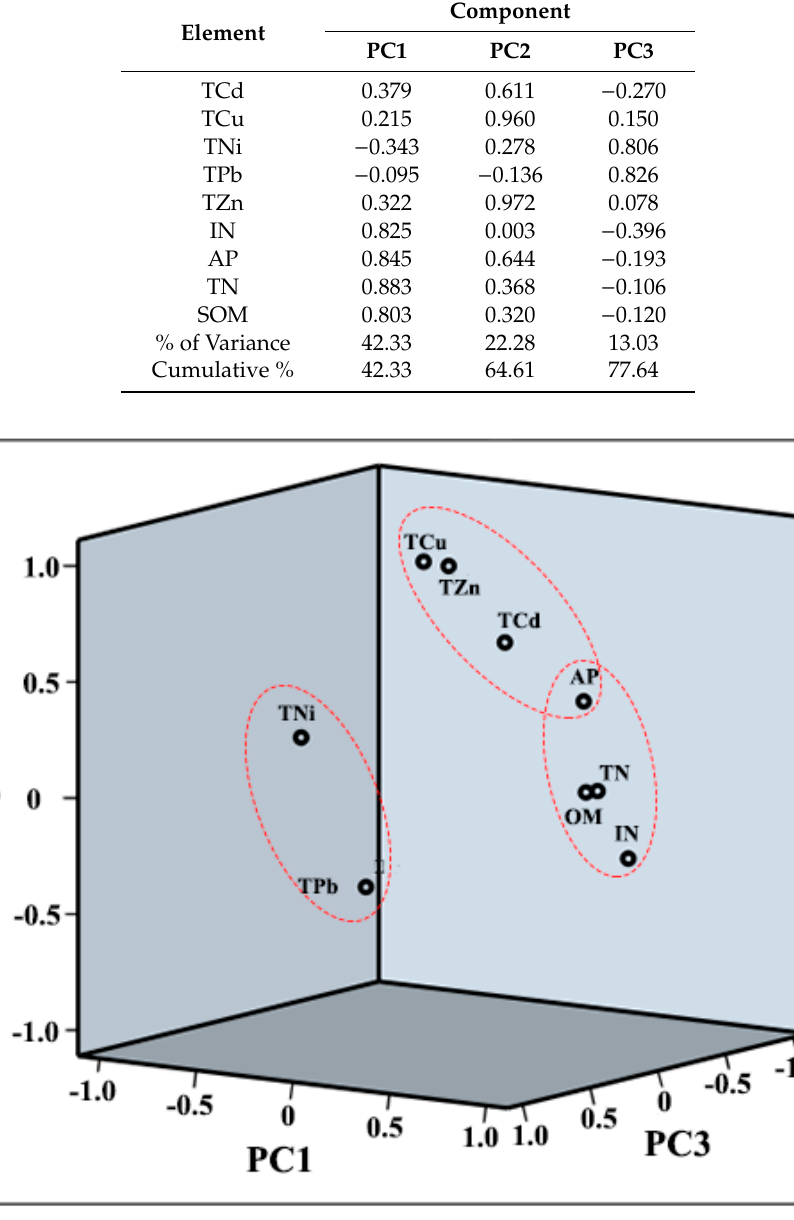
Figure 4. Factor loadings for the principal component analysis (PCA) of heavy metals in soils.